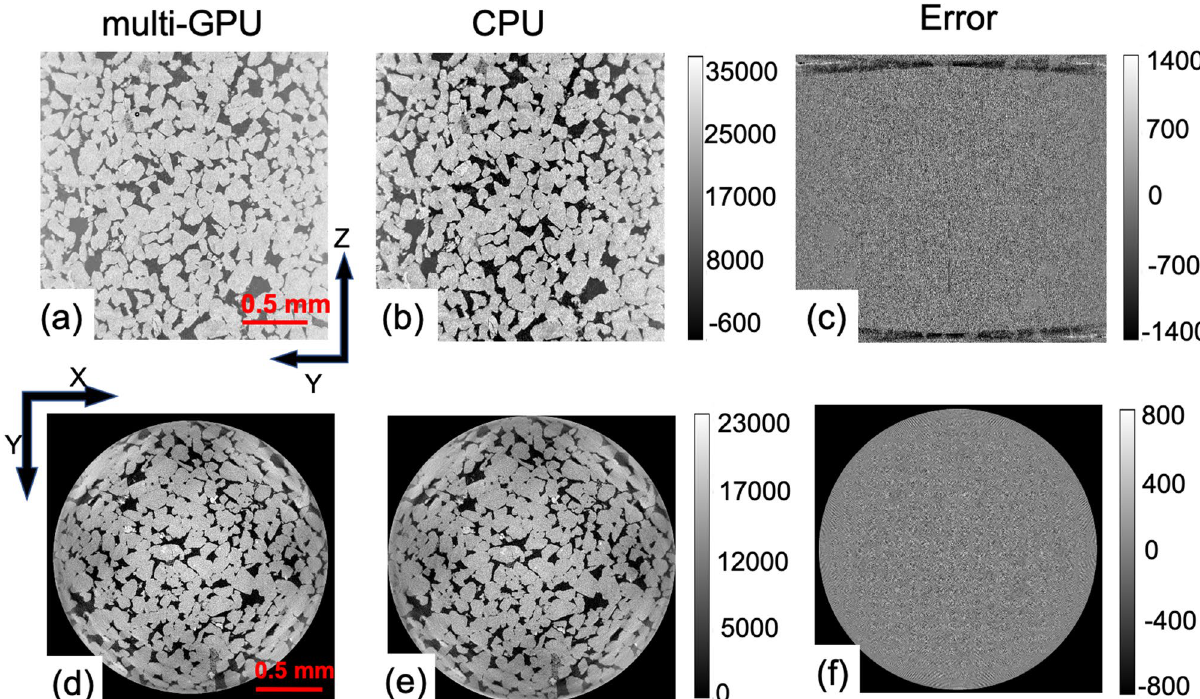
Figure 2. Comparison of MLEM reconstruction performance using multi-GPU and multi-core CPU architectures: ( a ) Reconstructed image using multi-GPU architecture along the Y–Z plane having X = 0. ( b ) Reconstructed image using multi-core CPU architecture along the Y–Z plane having X = 0. ( c ) The difference image of the multi-core CPU and multi-GPU implementations along the Y–Z plane having X = 0. (d) Reconstructed image using multi-GPU architecture along the X–Y plane having Z = 0. ( e ) Reconstructed image using multi-core CPU architecture along the X-Y plane having Z = 0. ( f ) The difference image between the multi-core CPU and multi-GPU implementations along the X–Y plane having Z =